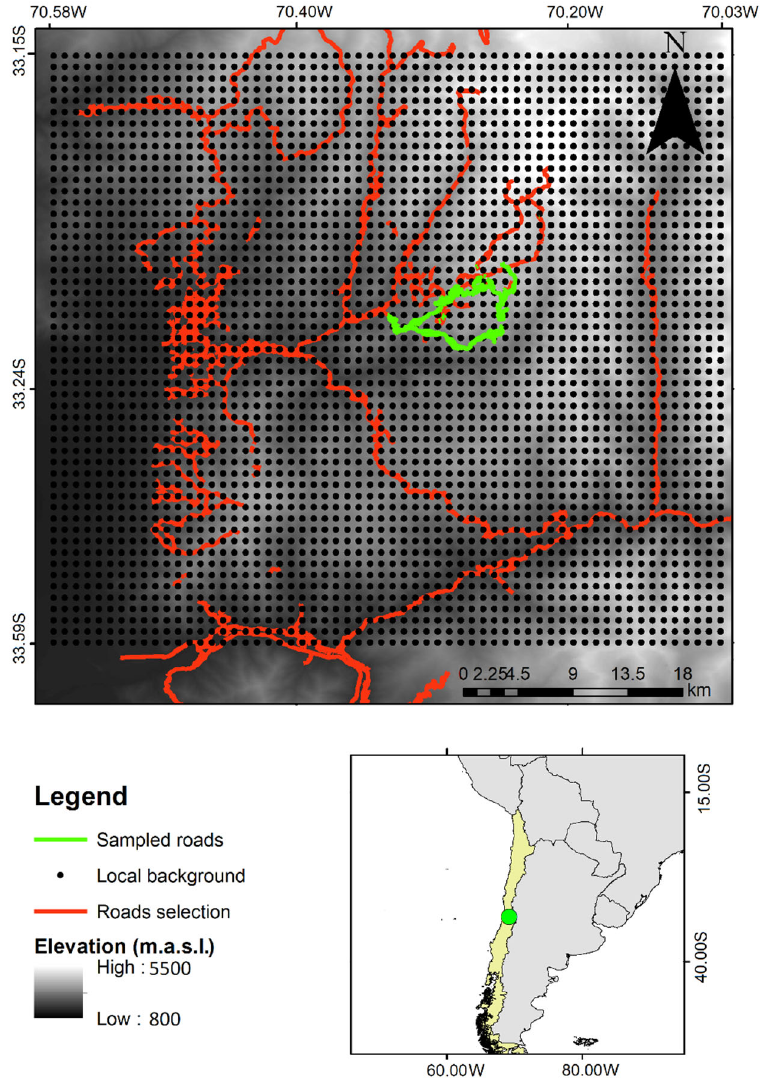
Figure 4. Study area depicting regularly sampled points to depict the regional climatic space. Local background is represented by 3180 geo-referenced points at a resolution f 30 arc sec (~1 km 2 ). The road network is shown in red and the mountain roads selected for this study are shown in green. The grayscale gradient depicts elevation (m